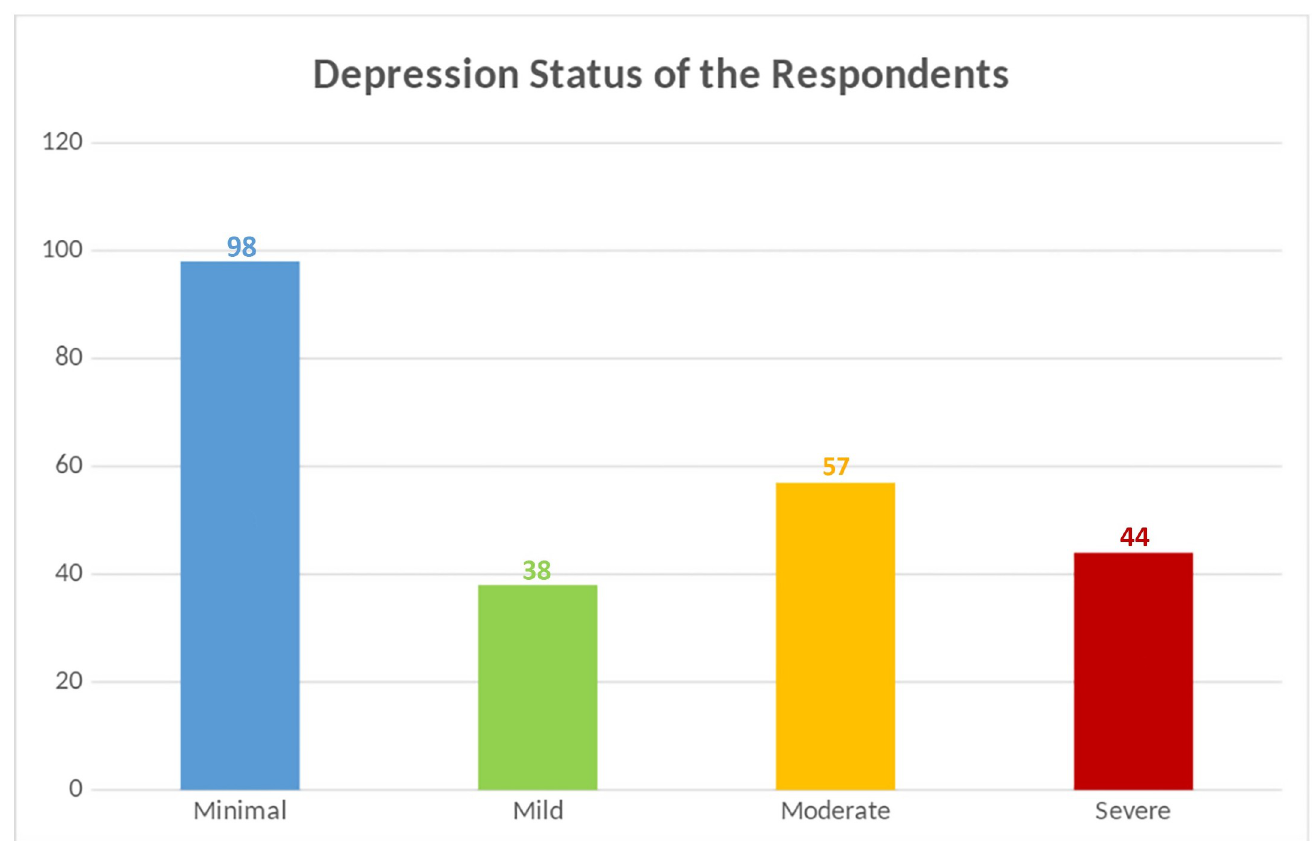
Fig 2. Depression status of the